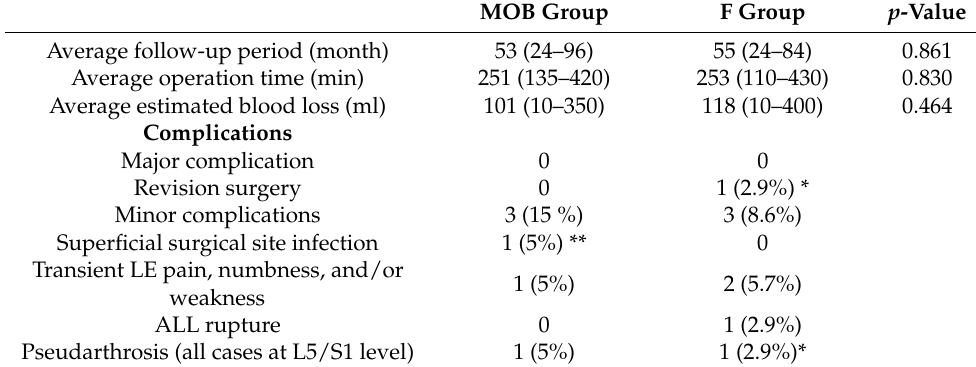
Table 2. Descriptive summarized results and complications in two groups.